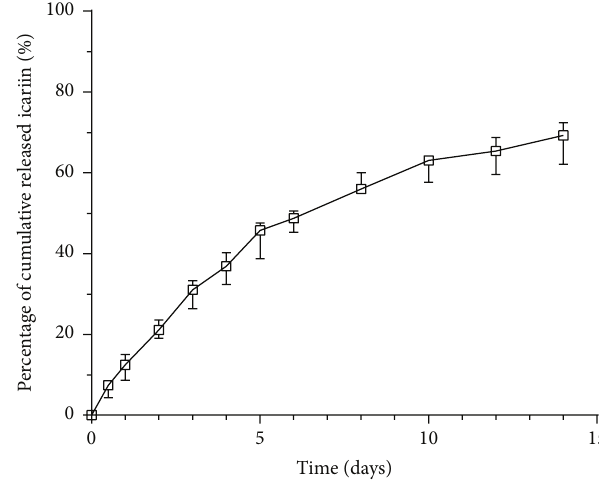
Figure 7: The in vitro release profile of icariin from a SMC- PHBHHx scaffold. All data are presented as mean values together with the standard deviation